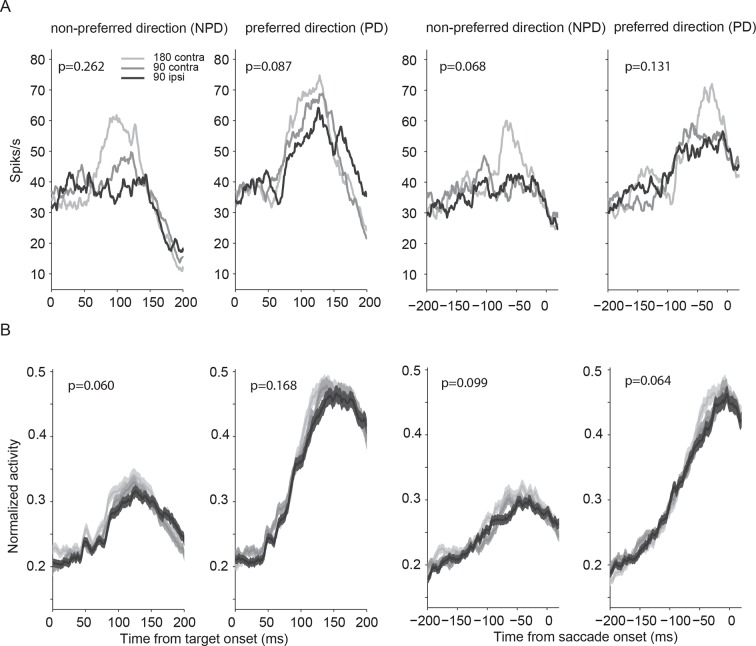
Neural activity modulated by the relative angle and position of the two targets.(A) The activity of a representative neuron aligned on target (two left columns) and saccade onset (two right columns) averaged over all possible pairs of target values. The first column and third column show the conditions when the non-preferred direction was chosen, the second and forth column show the conditions when the preferred direction was chosen. The color of the lines indicate the angle between the targets and their relative position in the visual field. Independent of whether the chosen saccade is into the preferred or non-preferred direction, the neural activity is least affected by targets that are far away (light gray; 180° apart). However, for alternative targets that are closer to the location of the chosen target, the neuron shows reduced activity (medium gray; 90° apart, contralateral hemifield), in particular when the target is in the same hemi-field (black; 90° apart, ipsilateral hemi-field). This indicates that spatially distinct targets evoke inhibitory interactions among SEF neurons that become stronger the closer the targets are to each other, independent of their value. (B) Average neural activity across 128 neurons. The plots show the same inhibitory effect as the representative neuron. The shaded areas represent SEM. SEF, supplementary eye field; SEM, standard error of the mean.